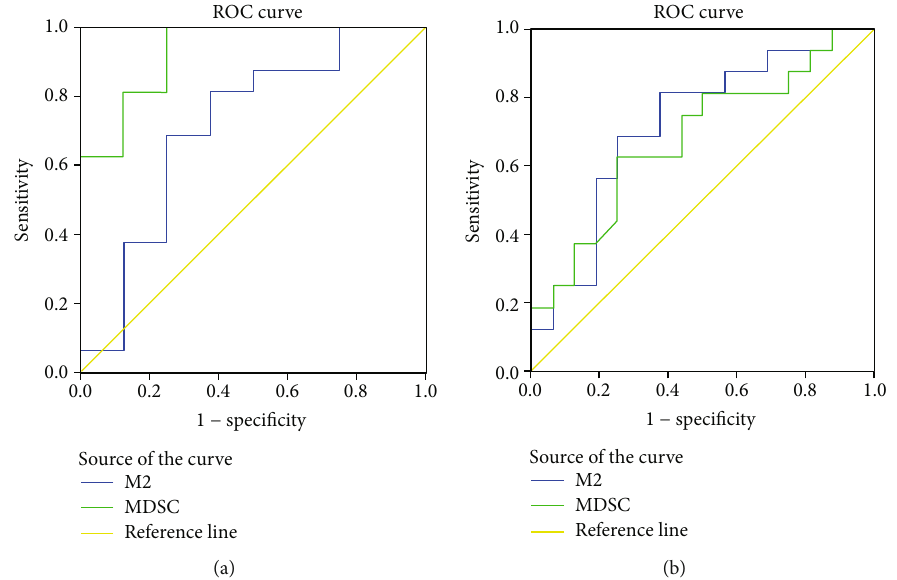
Figure 4: The ROC curve analysis about MDSCs and CD68 + CD163 + M2-like macrophages in NSCLC diagnosis and radiotherapy. (a) The ROC curve analysis in NSCLC diagnosis. (b) The ROC curve analysis in NSCLC radiotherapy. Table 2: ROC curve analysis about the diagnosis of NSCLC patients (area under the curve).